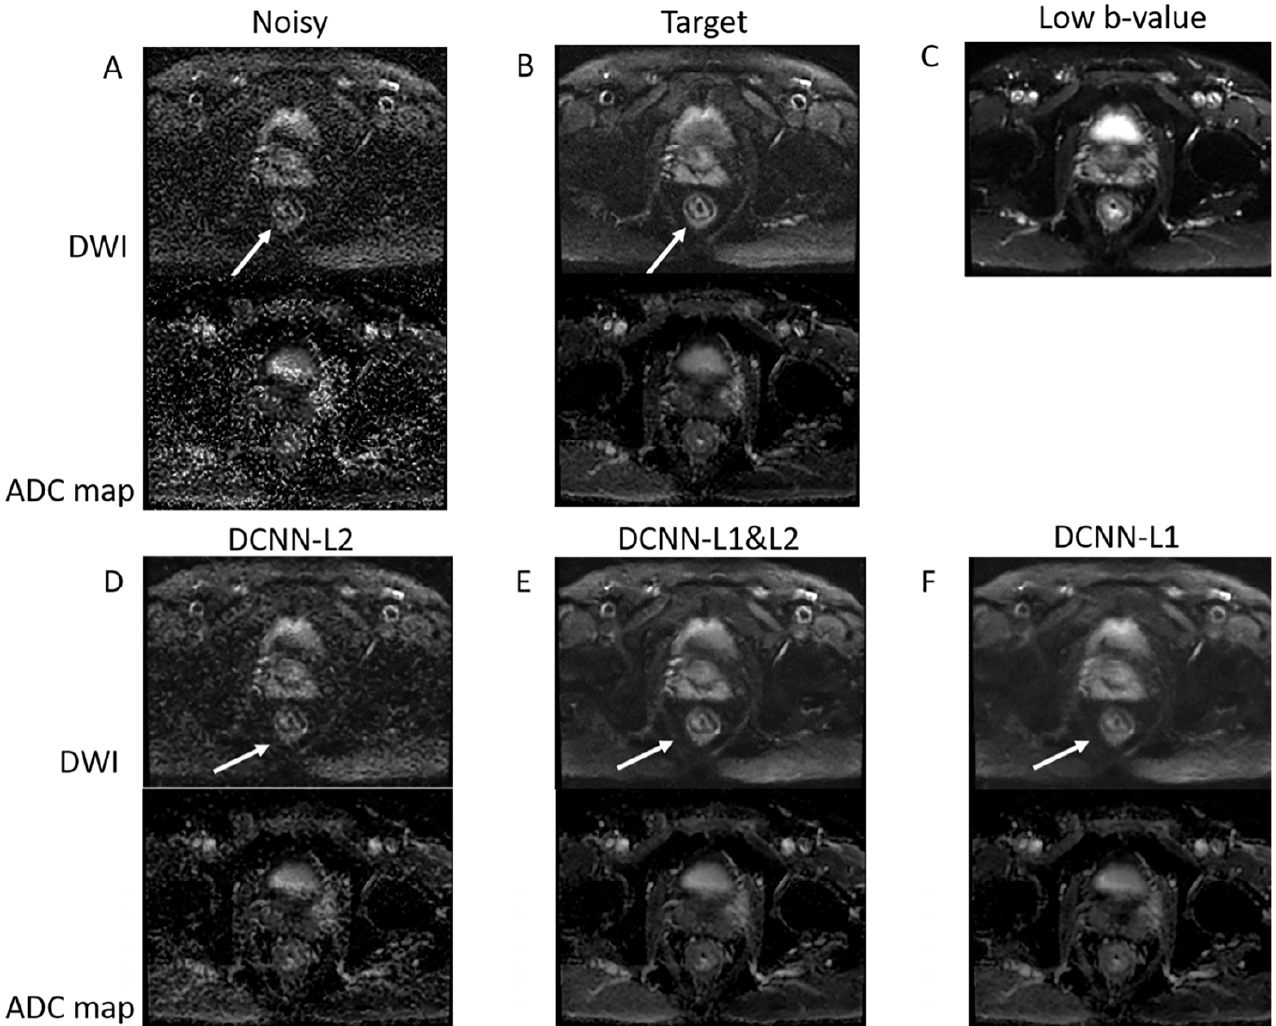
Figure 4. DCNN with different loss functions. ( A ) Noisy high b -value image reconstructed with NEX = 1 corresponding to an acquisition time of 22 s. ( B ) Target high b -value image with NEX = 16 corresponding to 370 s acquisition time. ( C ) Low b -value image used as a guide. ( D – F ) Denoised images were acquired with NEX = 1 using L2, joint L1–L2, and L1 loss functions. The joint L1–L2 loss function presents a better compromise between denoising and smoothing than L2 and L1 alone. Specifically, rectal wall layers (shown by the white arrow) are clearly improved when using the joint L1–L2 loss function. Table 2. PSNR and SSIM for high b -value noisy and denoised images (NEX = 1) with respect to the high b -value reference (NEX = 16) for different loss functions computed using all the patients in the testing set. Joint L1–L2 loss function presents the highest PSNR and SSIM, in agreement with the analysis performed by the body